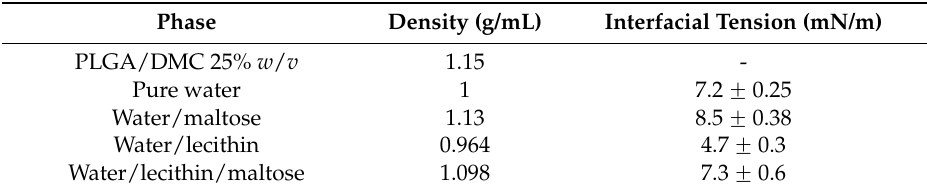
Table 2. Density of the phases of the studied emulsions; interfacial tensions between the studied dispersed phases and the PLGA/DMC solution.